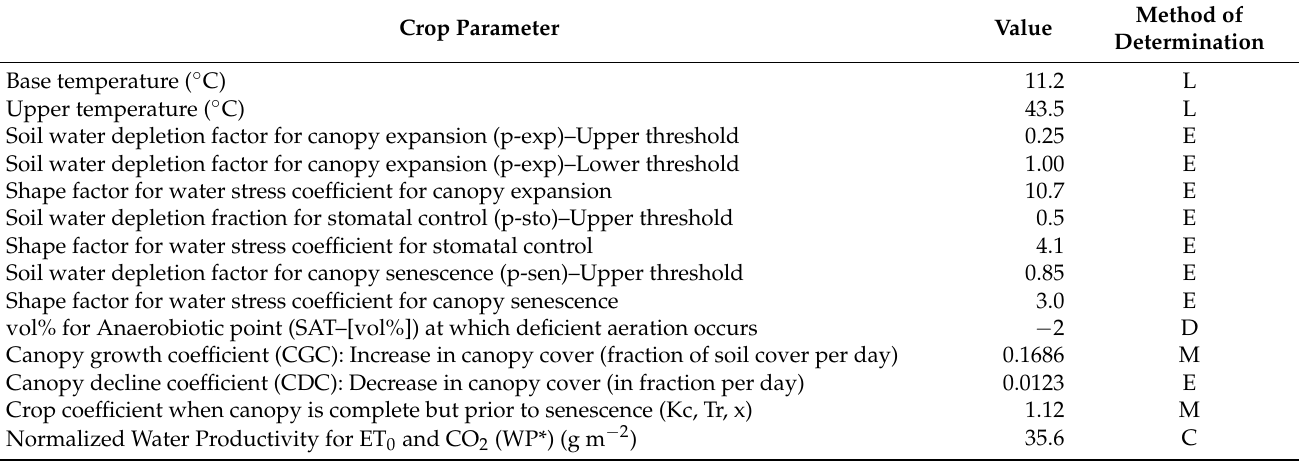
Crop Parameter Value